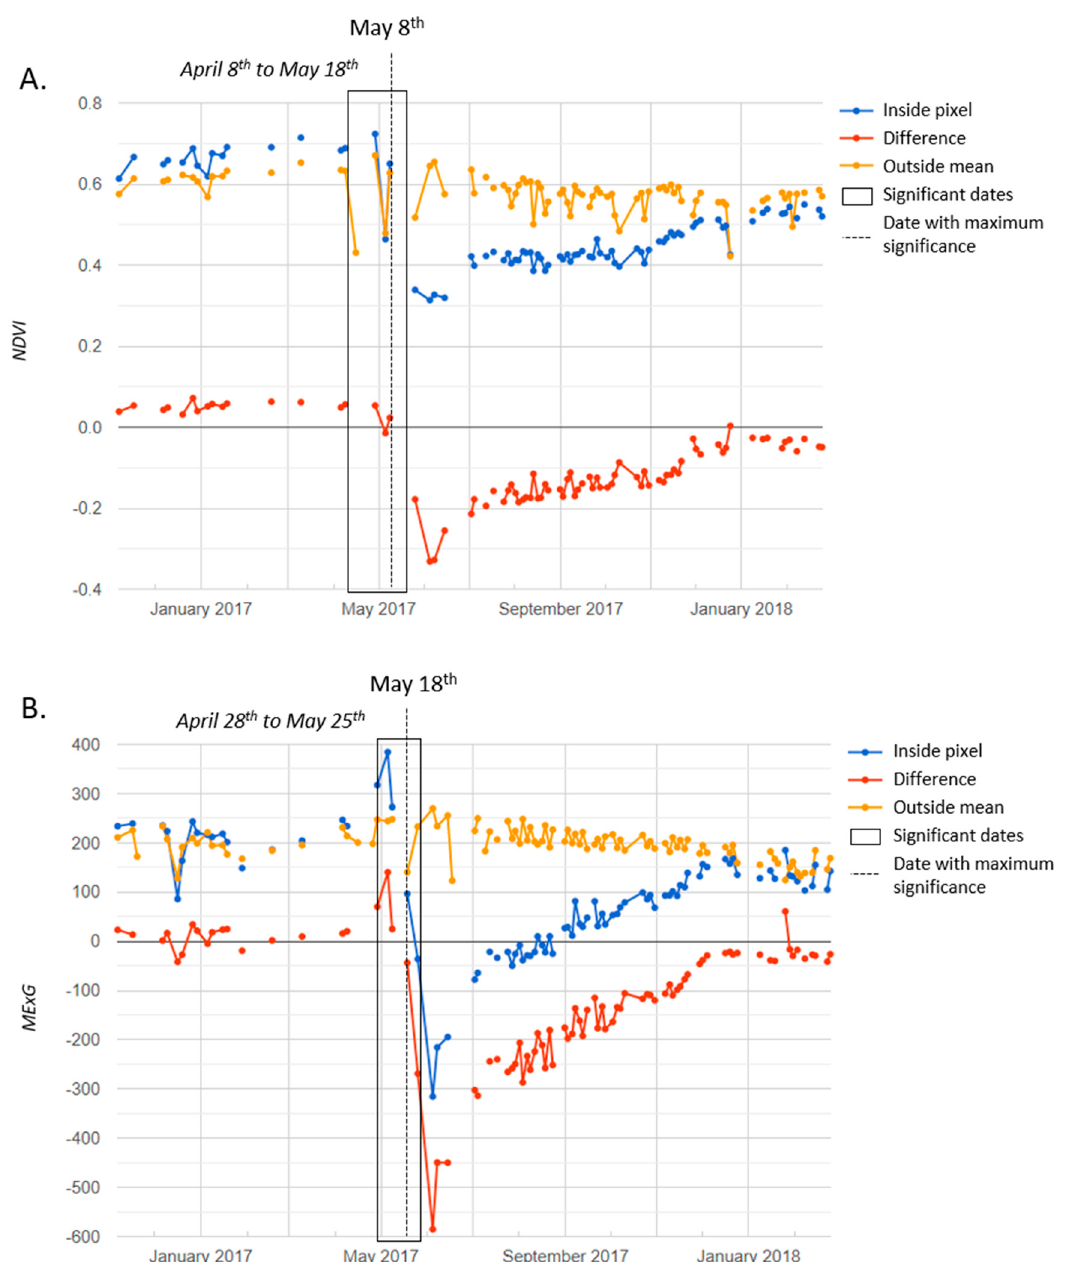
Figure 6. Example of the three time series (“inside pixel” in blue, “outside mean” in yellow, “di ff erence” in red) in Serra de Candeeiros (shrubs) for ( A ). NDVI and ( B ). MExG, with all significant dates (black rectangle) and the maximum significant date (vertical dash line), for a one-sided Welch’s test with α = 0.05.